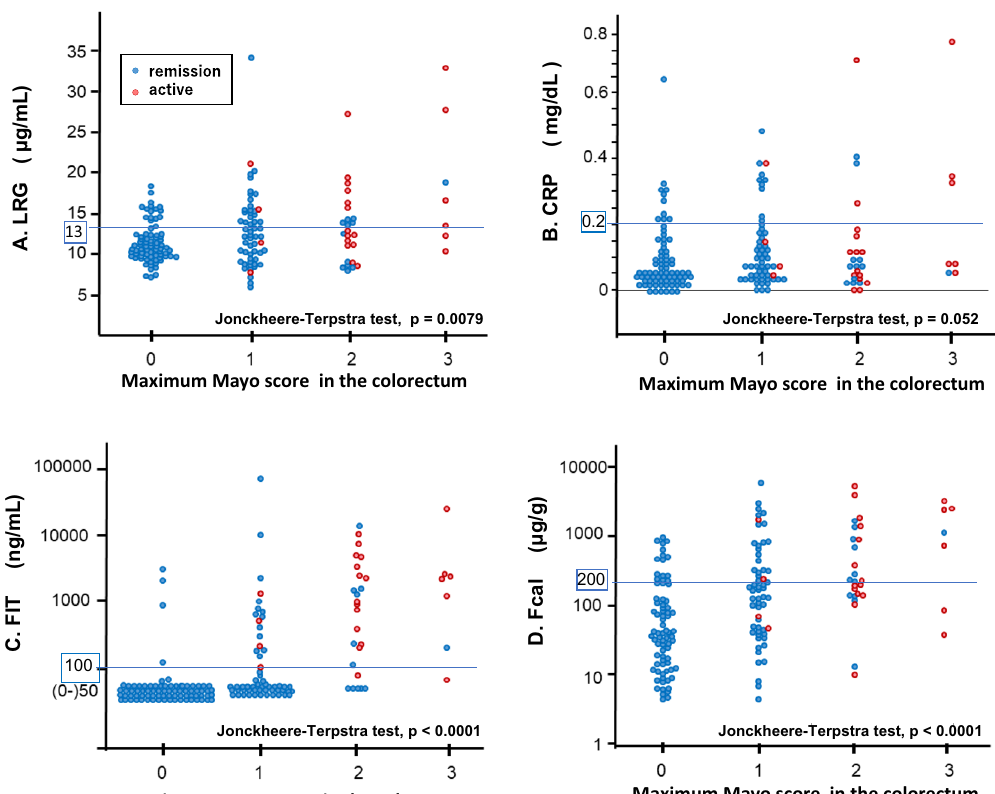
Figure 2. Correlation between the serum/fecal biomarkers and maximum MES in UC patients. ( A ) LRG, ( B ) CRP, ( C ) FIT, ( D ) Fcal. MES mayo endoscopic subscore, UC ulcerative colitis, LRG leucine-rich alpha-2 glycoprotein, CRP C-reactive protein, FIT fecal immunochemical test, Fcal fecal calprotectin. The red dots indicate the values of patients with active stage and the blue dots indicate the values of patients with remission stage. The specimens with a hemoglobin concentration within this range (0–50 ng/mL) were handled as category, because FIT is not accurate for measuring hemoglobin concentrations of < 50 ng/mL. Parallel blue lines showed the cutoff values of serum/fecal biomarkers in this study (LRG: 13.0 µg/mL, CRP: 0.20 mg/dL, FIT: 100 ng/mL, and Fcal: 200 µg/g).